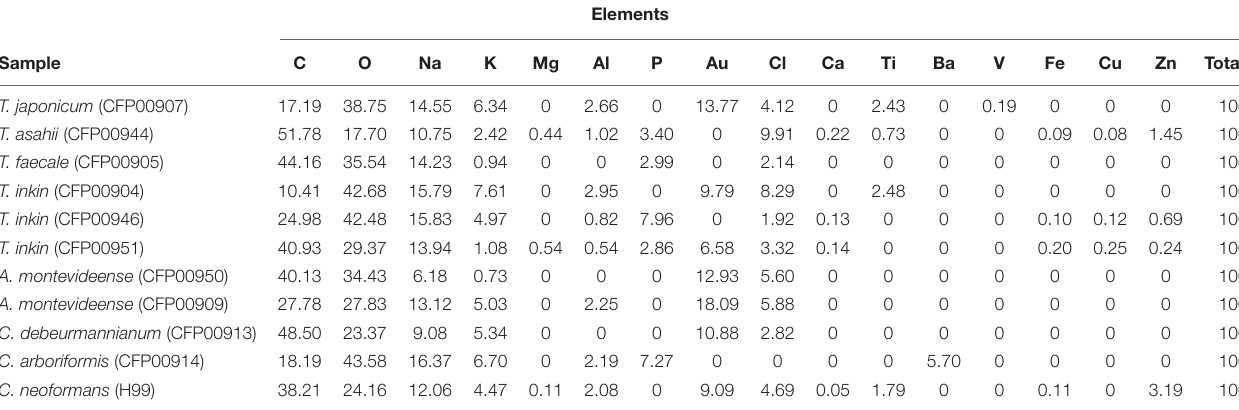
TABLE 1 | Composition of chemical elements present in Trichosporonaceae and C. neoformans melanin samples.